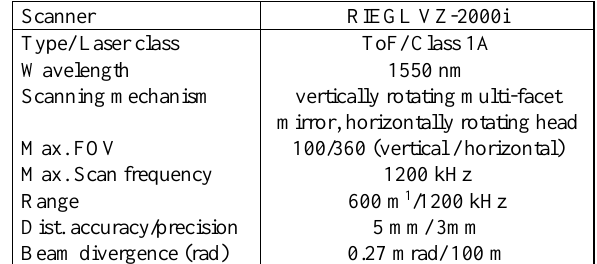
Table 1. Technical properties of RIEGL VZ-2000i